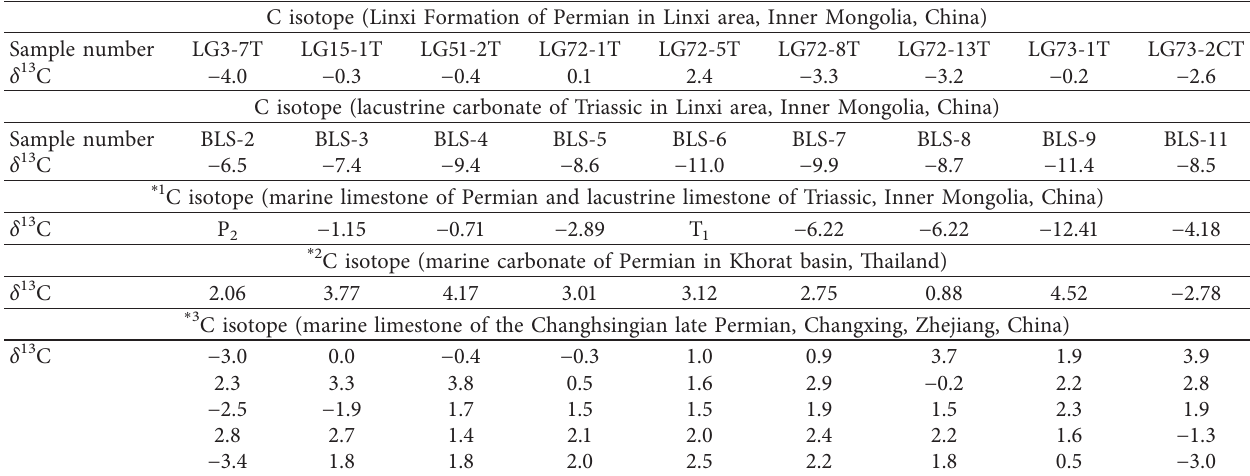
Table 3: Carbon isotopic data of Permian-Early Triassic carbonate rocks in Linxi area and other regions. C isotope (Linxi Formation of Permian in Linxi area, Inner Mongolia,